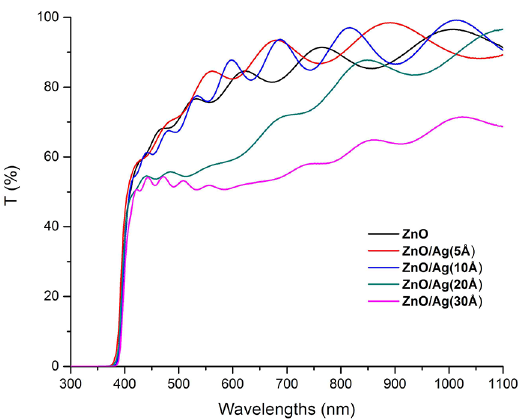
Figure 10. " Envelope method" graph including extremum values for thickness measurement The calculations of Table 6 correspond to the undoped ZnO sample deposited at 375℃ using Eq. (10) and the average thickness of 1378 nm was obtained for this sample.